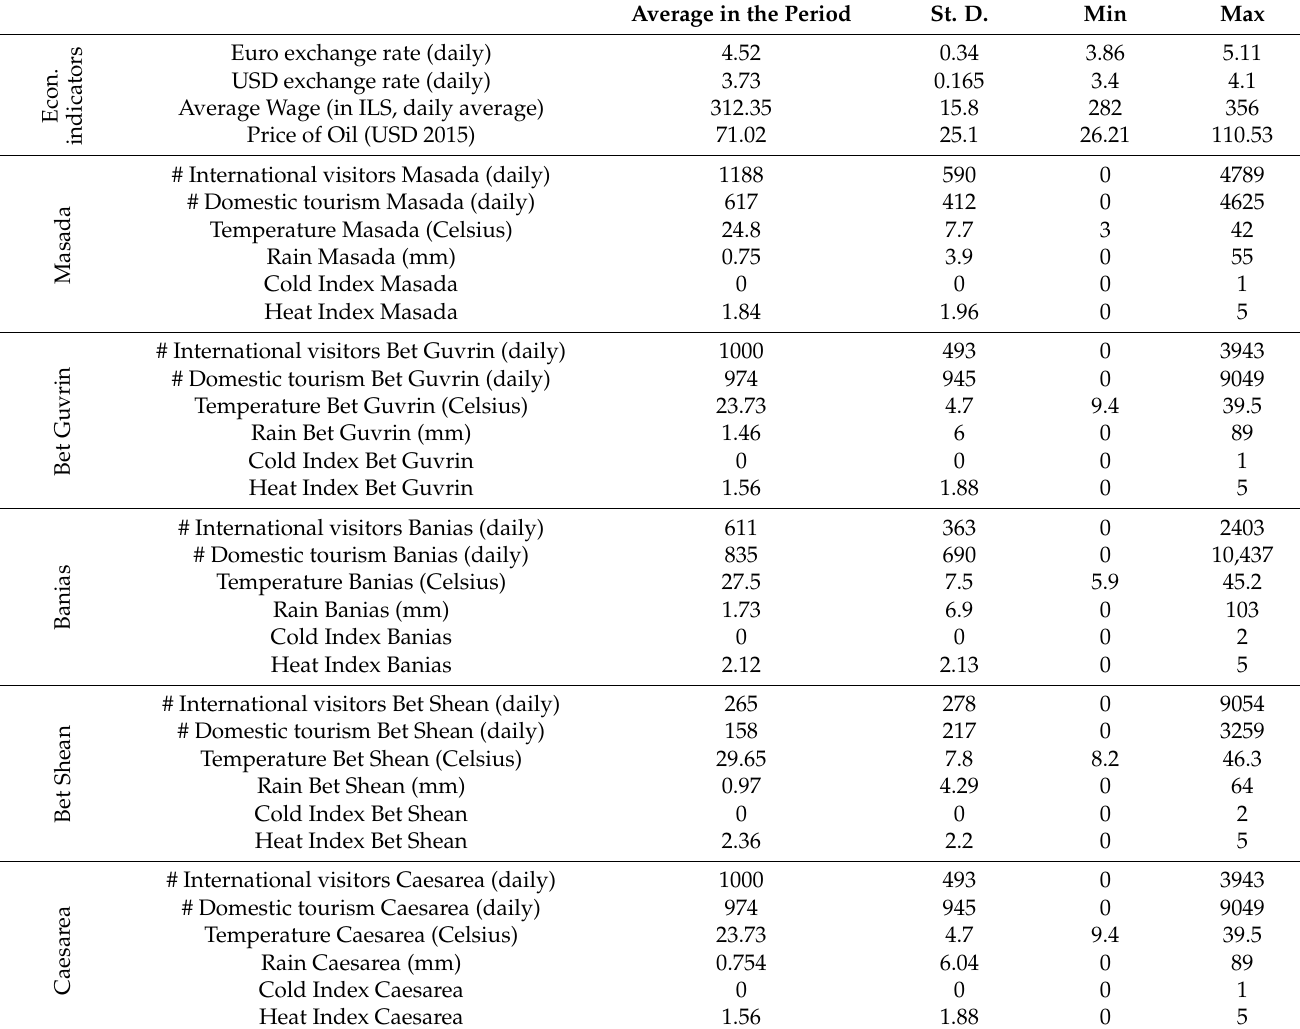
Table 1. Descriptive statistics of the